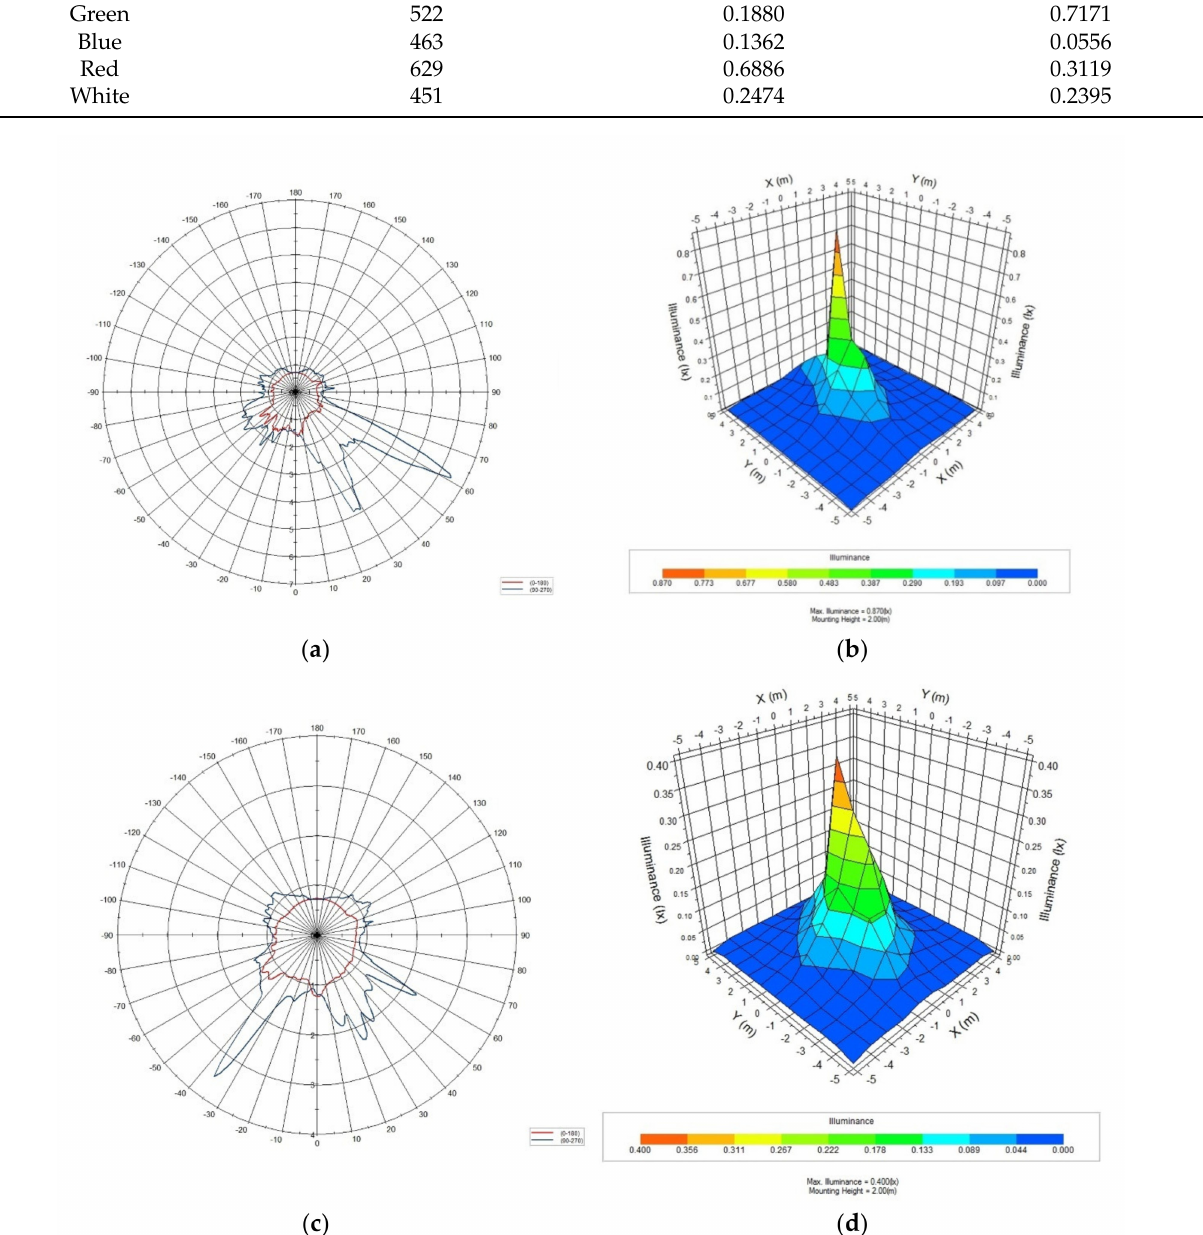
Figure 1. The polar distribution and ISO lux diagrams for the LED lights used for the experiments by integrating the sphere device and goniophotometer system: ( a ) polar distribution of green LED; ( b ) ISO lux diagram of green LED; ( c ) polar distribution of white LED; ( d ) ISO lux diagram of green